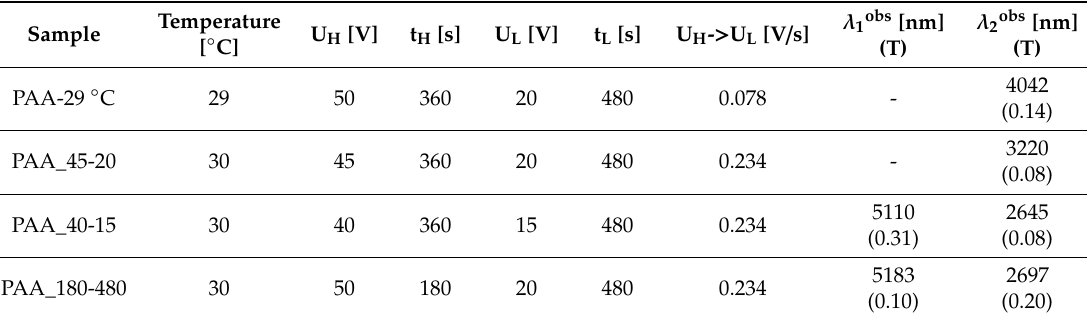
Table 1. Electrochemical parameters applied during a 20-cycle pulse anodization at relatively high temperatures, which was used to synthesize PAA-based DBRs with the best optical properties along with the observed PSBs (T stands for transmission